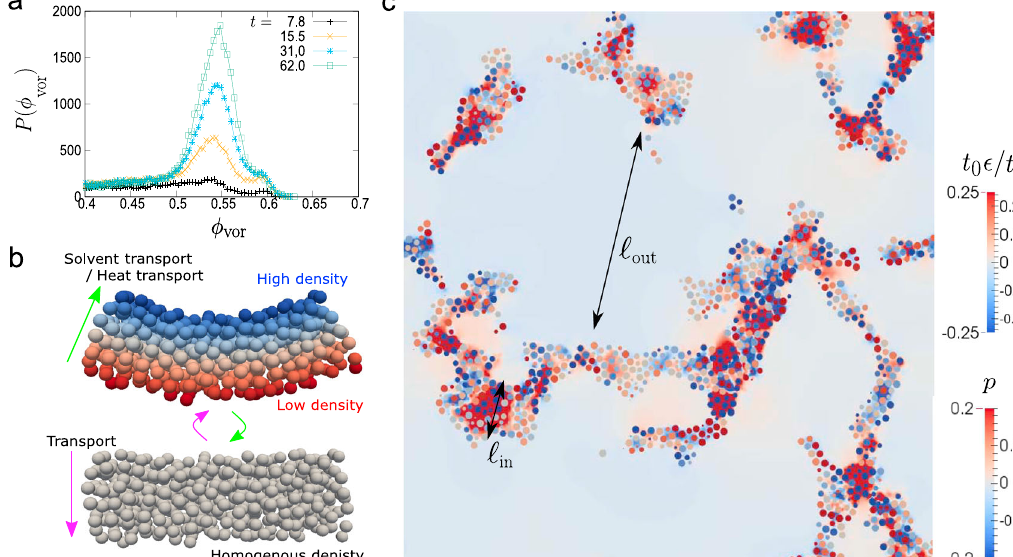
Fig. 4 The origin of self-similarity and the key material transport mechanism. a The distribution function of the local volume fraction of each particle, ϕ ¼ πσ 3 , where V vor is the volume of the Voronoi cell of each particle. In the early stage, since most of the particles are located at the interface of the vor 6 V vor colloid-rich phase, or having only a few neighbouring particles (~6) (much less than in bulk (~12)), the distribution is very fl at. However, in the late stage ( t ≳ 31.0), we can see a rather sharp peak. The local volume fraction in the colloid-rich phase in the late stage is approximately estimated as ϕ 0.03 and almost constant with time. b A schematic illustration of poroelastic and thermoelastic deformations. Elastic volumetric deformation of the dense colloidal domain must involve the solvent transport inside the domain. For example, when the rod-like domain is deformed from the bottom to the top con fi guration in panel b , the colloid volume fraction increases (decreases) in the upper (lower) part of the domain, accompanying the transport of the solvent from the upper to the lower part (see the magenta arrows). For a single-component fl uid, on the other hand, heat transport takes place instead of solvent transport, but the underlying physics is to be the same. The green arrows indicate the reverse process. c Visualisation of elastic deformation with the solvent exchange by a 2D slice of the phase-separation structure at t = 62. The circles represent the cross-sections of colloidal spheres, and the particle colour is labelled according to the scaled local volume deformation introduced in Fig. 5c. The colour in the background (i.e., outside the particles) shows the pressure fi eld of the solvent.